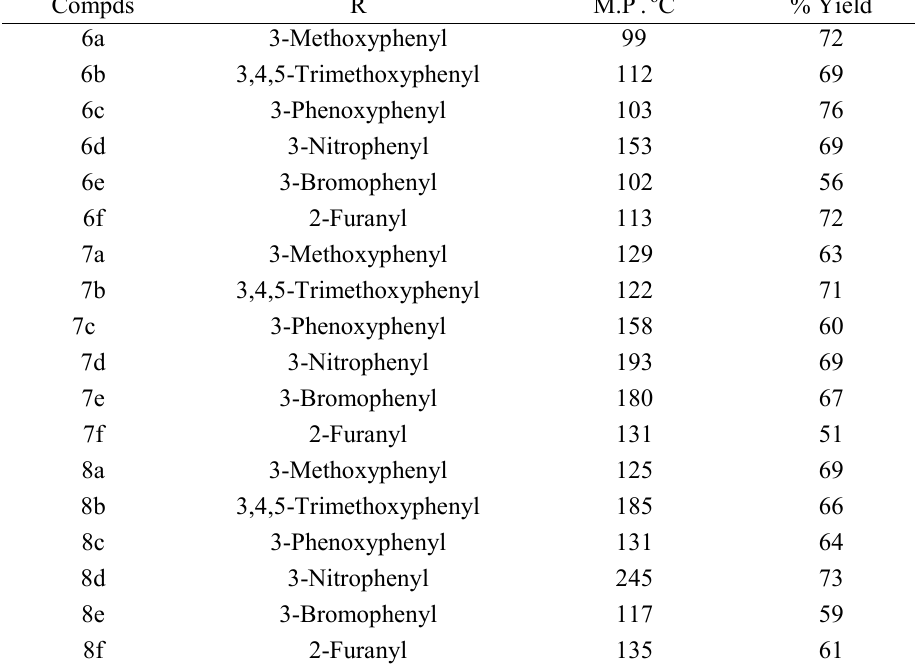
Table 1. Characterization data of compounds (6a-f), (7a-f) and